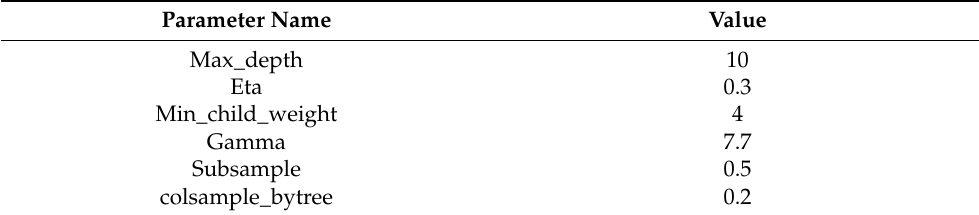
Table 7. The optimal combination of